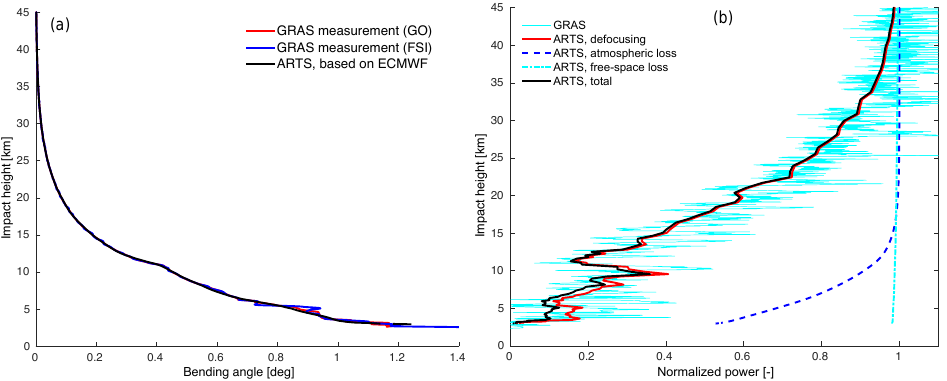
Figure 5. Comparison of ARTS forward model calculations with GRAS data. The input to ARTS is ECMWF operational analysis data. Panel (a) compares ARTS simulations to observed bending angles determined in two different ways from raw GRAS observations. Panel (b) shows the observed and simulated link budget for transmitted power. As is common for radio occultation observations, the vertical scale is impact height, which is simply the impact parameter of Fig. 4 minus the Earth